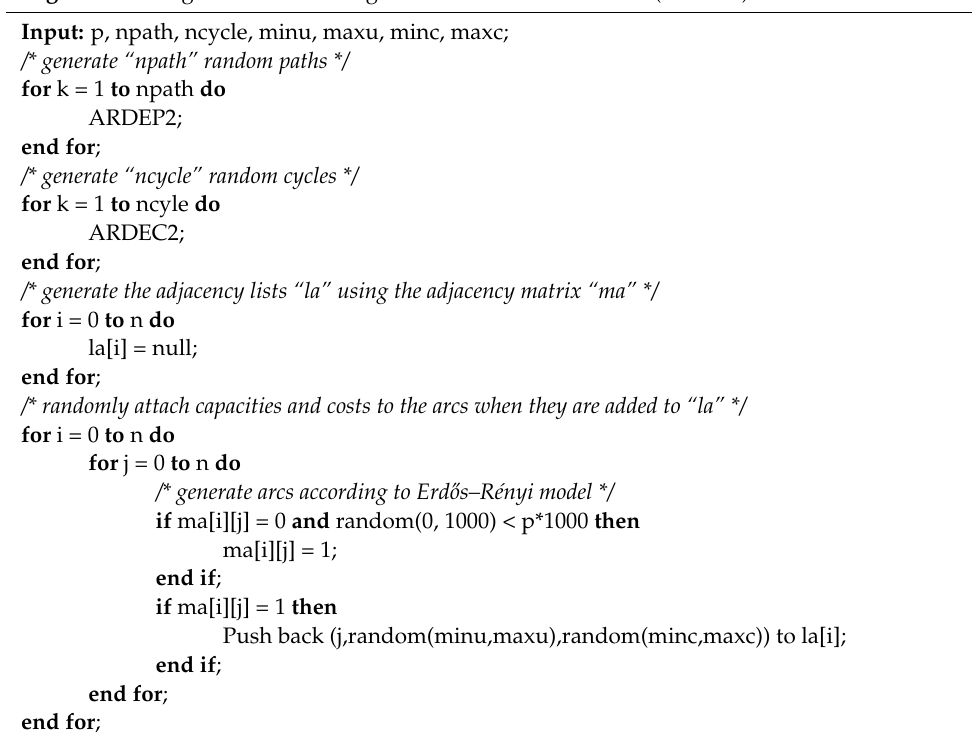
Algorithm 7. Algorithm Generating Random s-t Flow Network